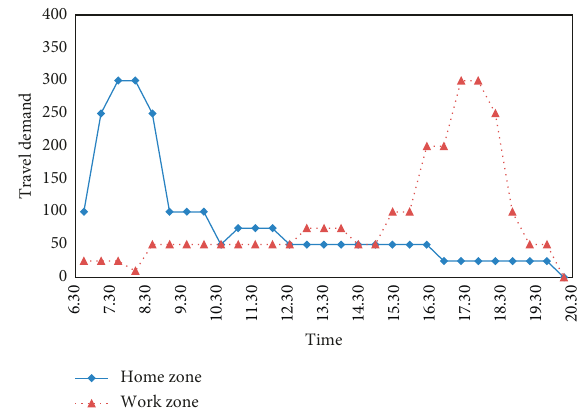
Figure 6: Distribution of travel demand from zones 1 and